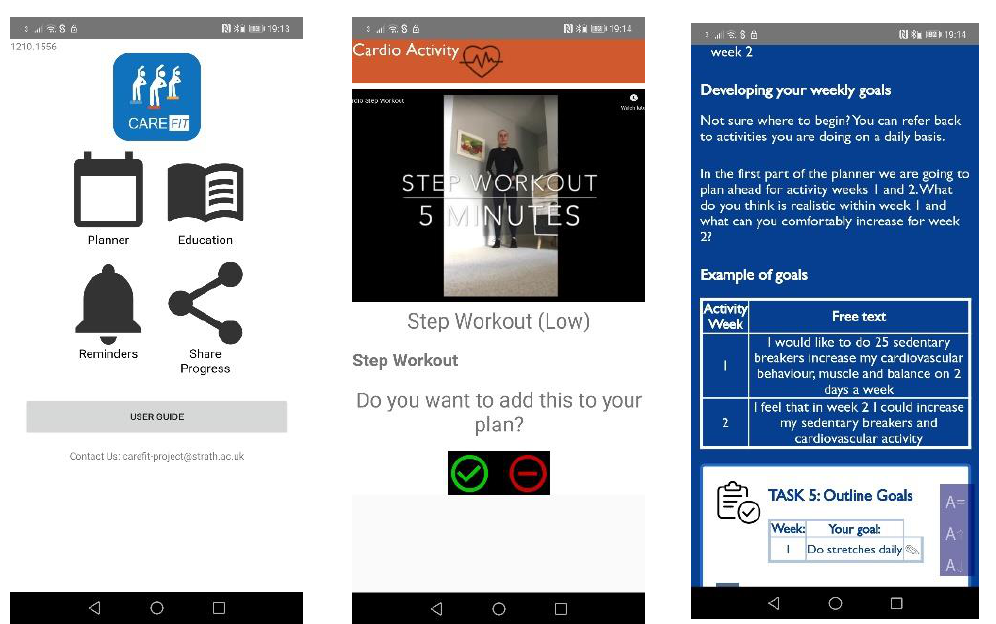
Figure 1. Visuals of the prototype used within the “CareFit” 3-week test study including the Main Menu ( Left ), Physical activity ( Middle ) and educational section ( right ).